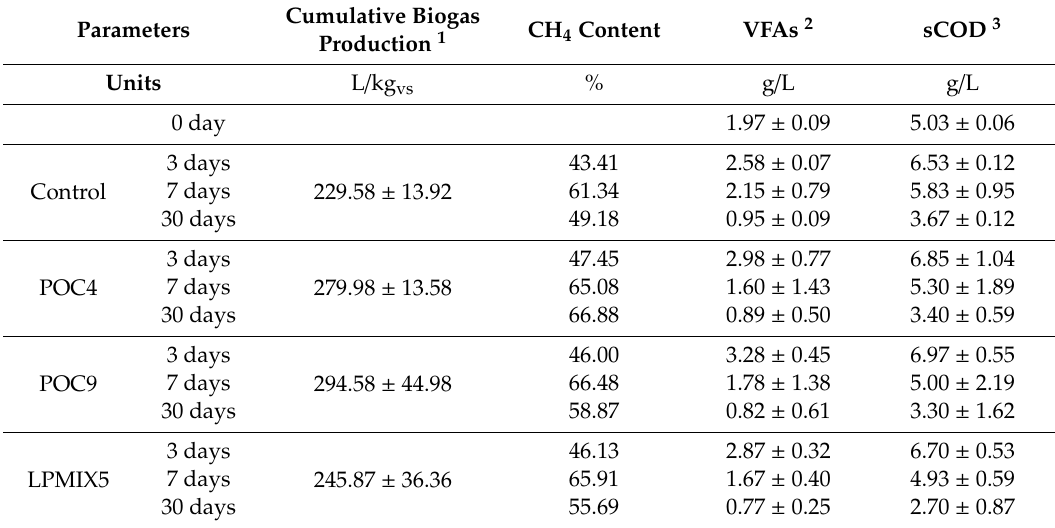
Table 3. Physico-chemical characteristics of the anaerobic digestion process. The experiment was performed in three replicates. Standard deviations are included in the